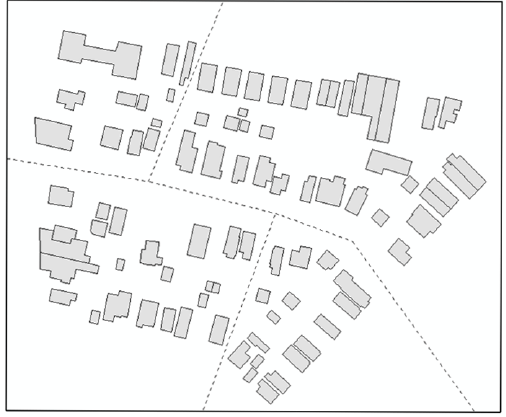
Figure 6. The clustering result obtained by human cognition on experimental region b . Table 2. Weight scheme trained by the Relief-F algorithm.